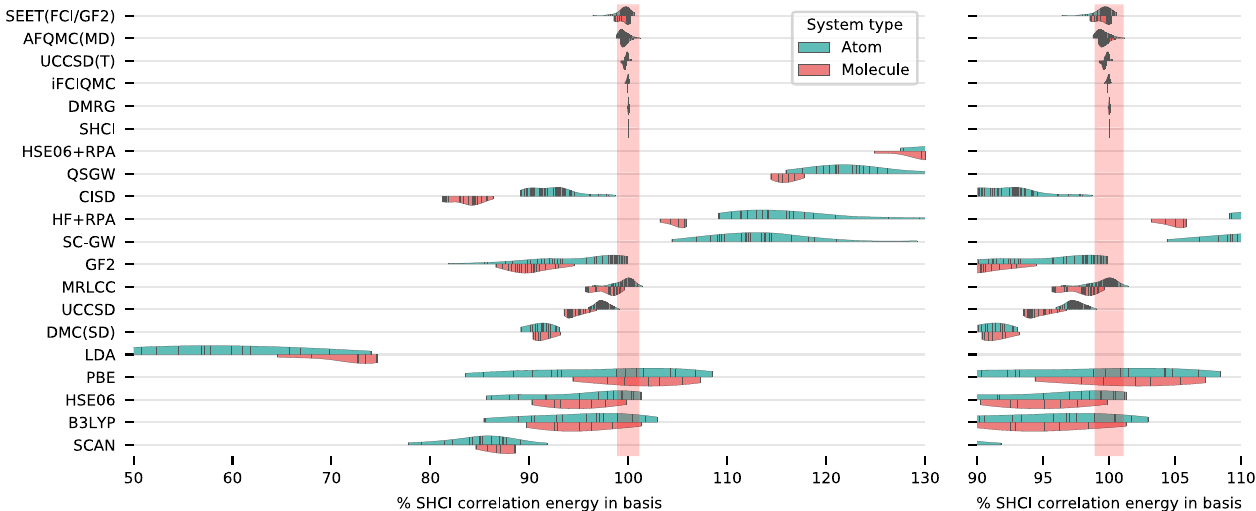
FIG. 2. Kernel density estimation [65 – 67] of the percent of the SHCI-computed correlation energy within each basis obtained by each of the methods in the benchmark set. All basis sets available are plotted; individual data points are indicated by small